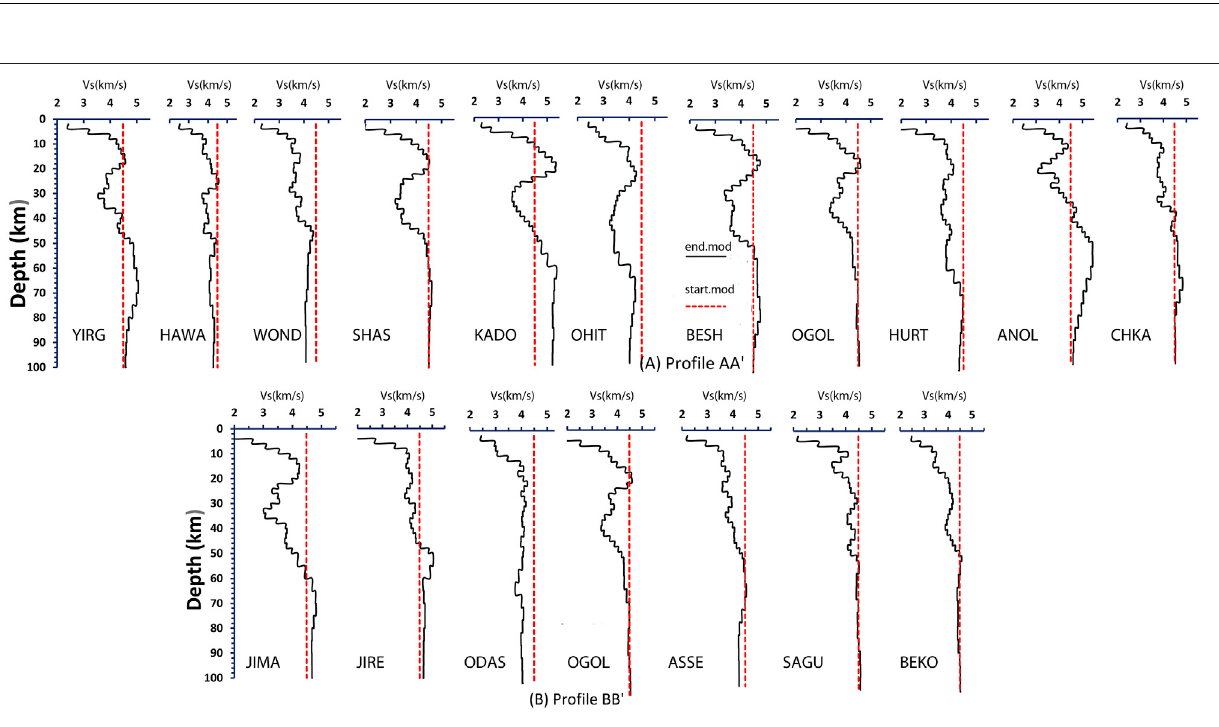
Frontiers in Earth Science |